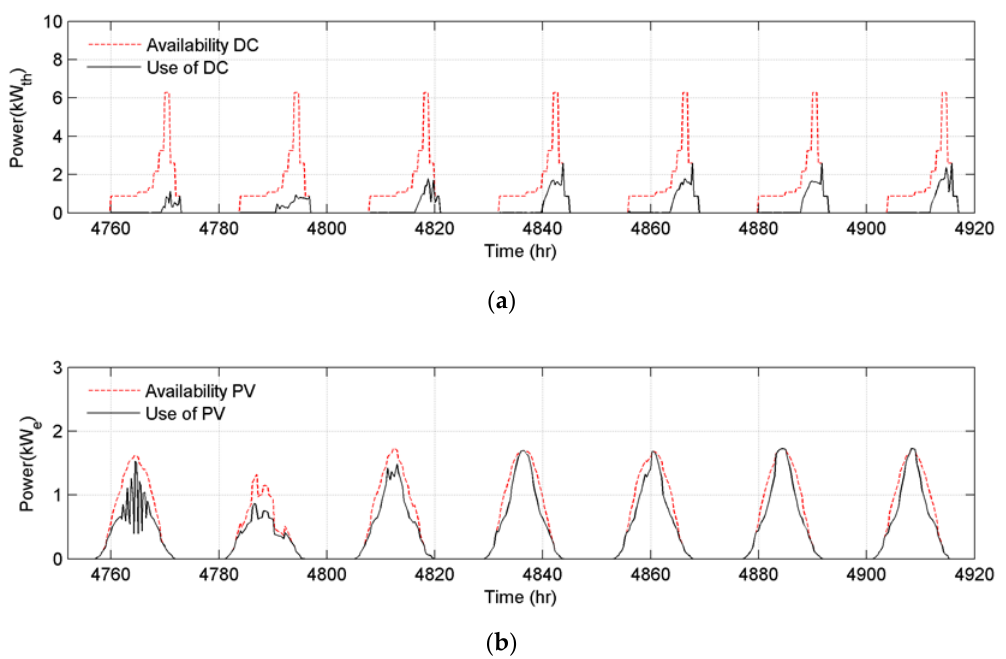
Figure 13. Energy sources used to cover the weekly cooling demand of the building compared to the availability profiles with MPC (OF C , PH of 18 h): ( a ) DC; ( b ) PV.